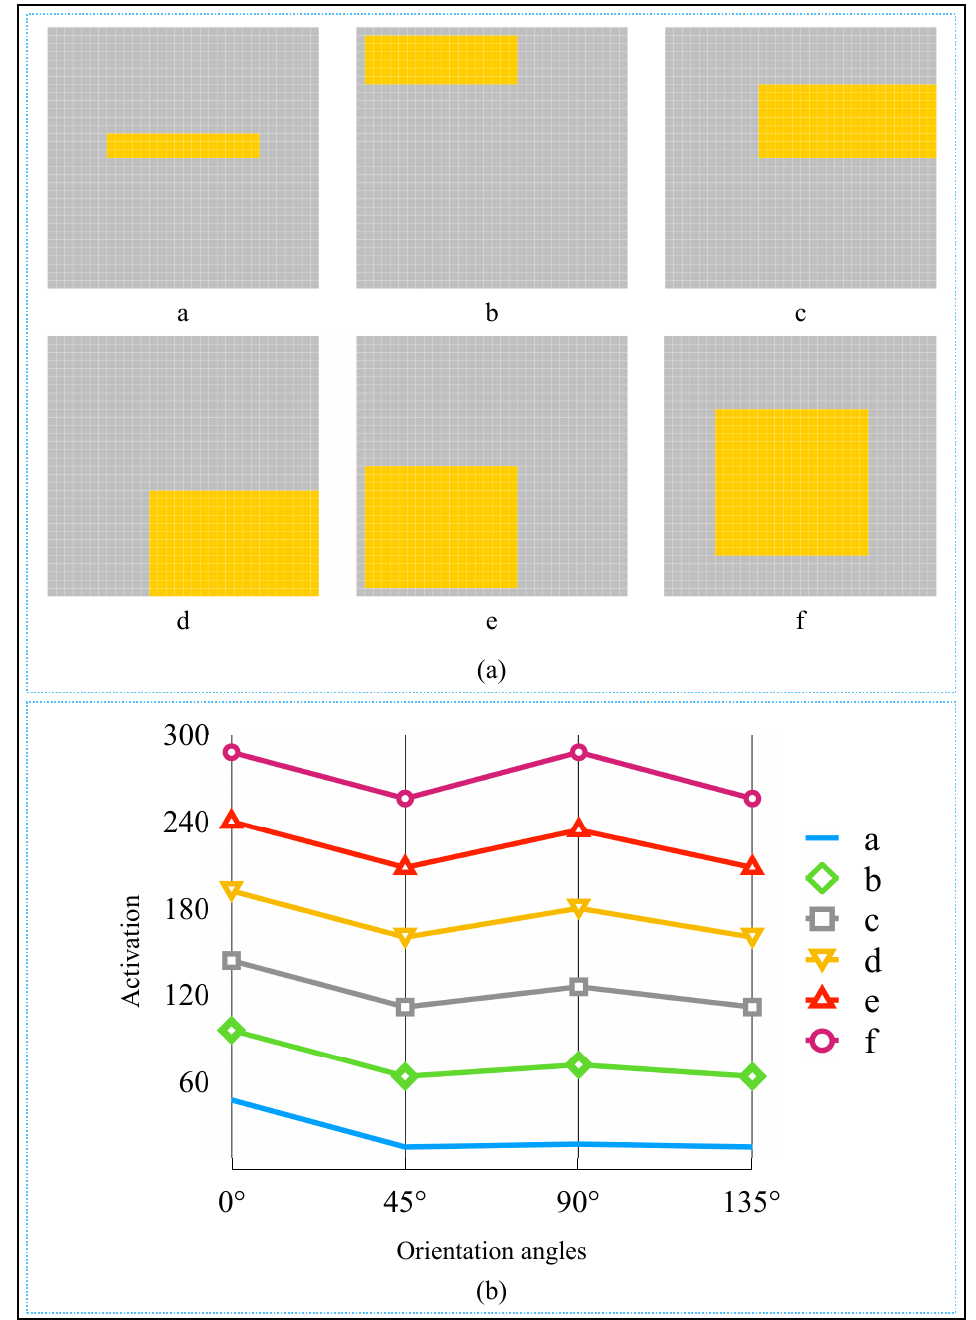
Figure 16. The detected objects and activation curves. ( a ) The objects to be detected. ( b ) Spike rate curves of complex cells on six